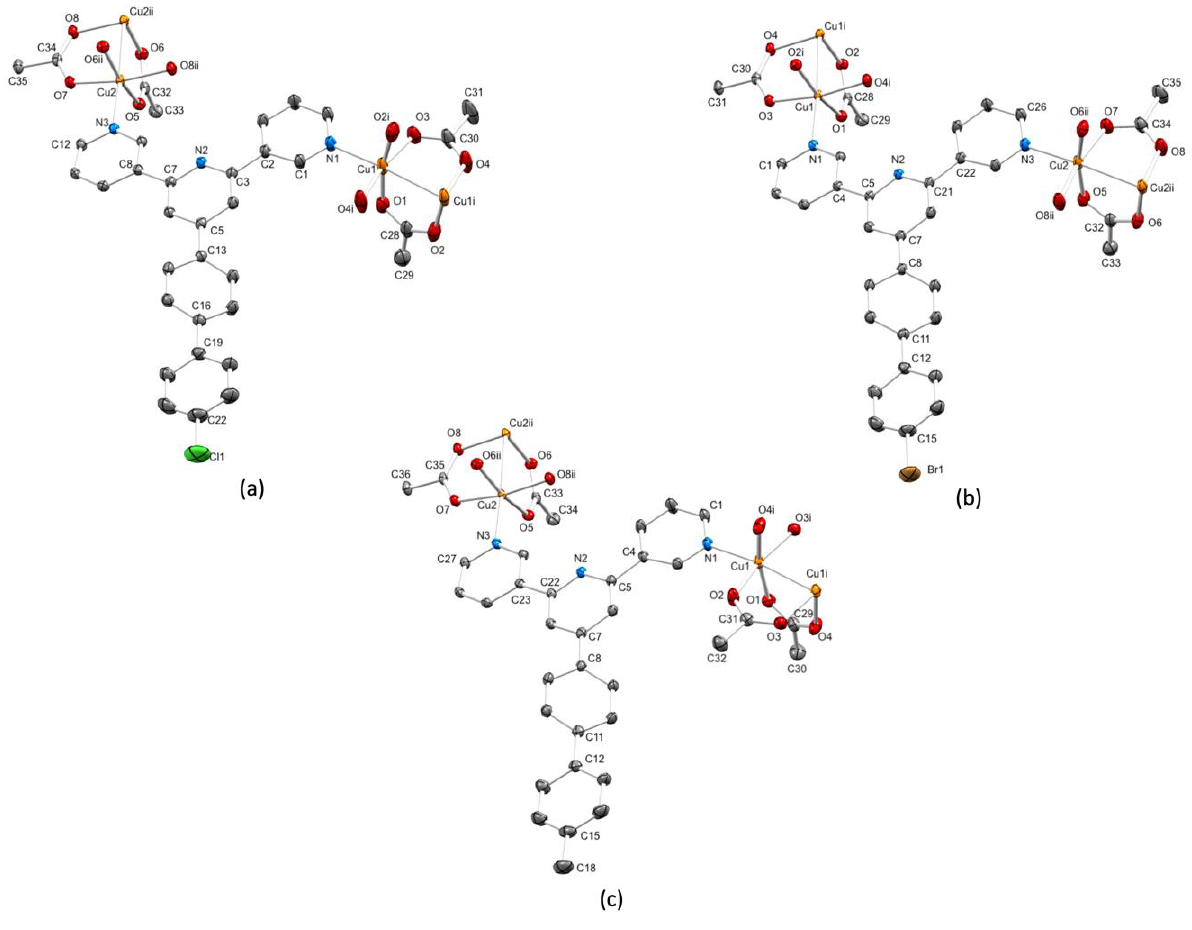
Figure 3. The repeat units (with symmetry generated atoms) in ( a ) [Cu 2 (μ -OAc) 4 ( 2 )] n (ellipsoids plotted at 50% probability level; symmetry codes: i = 1 − x , y , 3 / 2 − z ; ii = 3 / 2 − x , 1 / 2 − y , 1 − z ; iii = − 1 / 2 + x , 1 / 2 − y , 1 / 2 + z ) and ( b ) [Cu 2 (μ -OAc) 4 ( 2 )] n (ellipsoids plotted at 40% probability level; symmetry codes: i = 1 − x , y , 1 / 2 − z ; ii = 1 / 2 − x , 3 / 2 − y , 1 − z ; iii = 1 / 2 + x , 3 / 2 − y , − 1 / 2 + z ). H atoms are omitted for clarity.